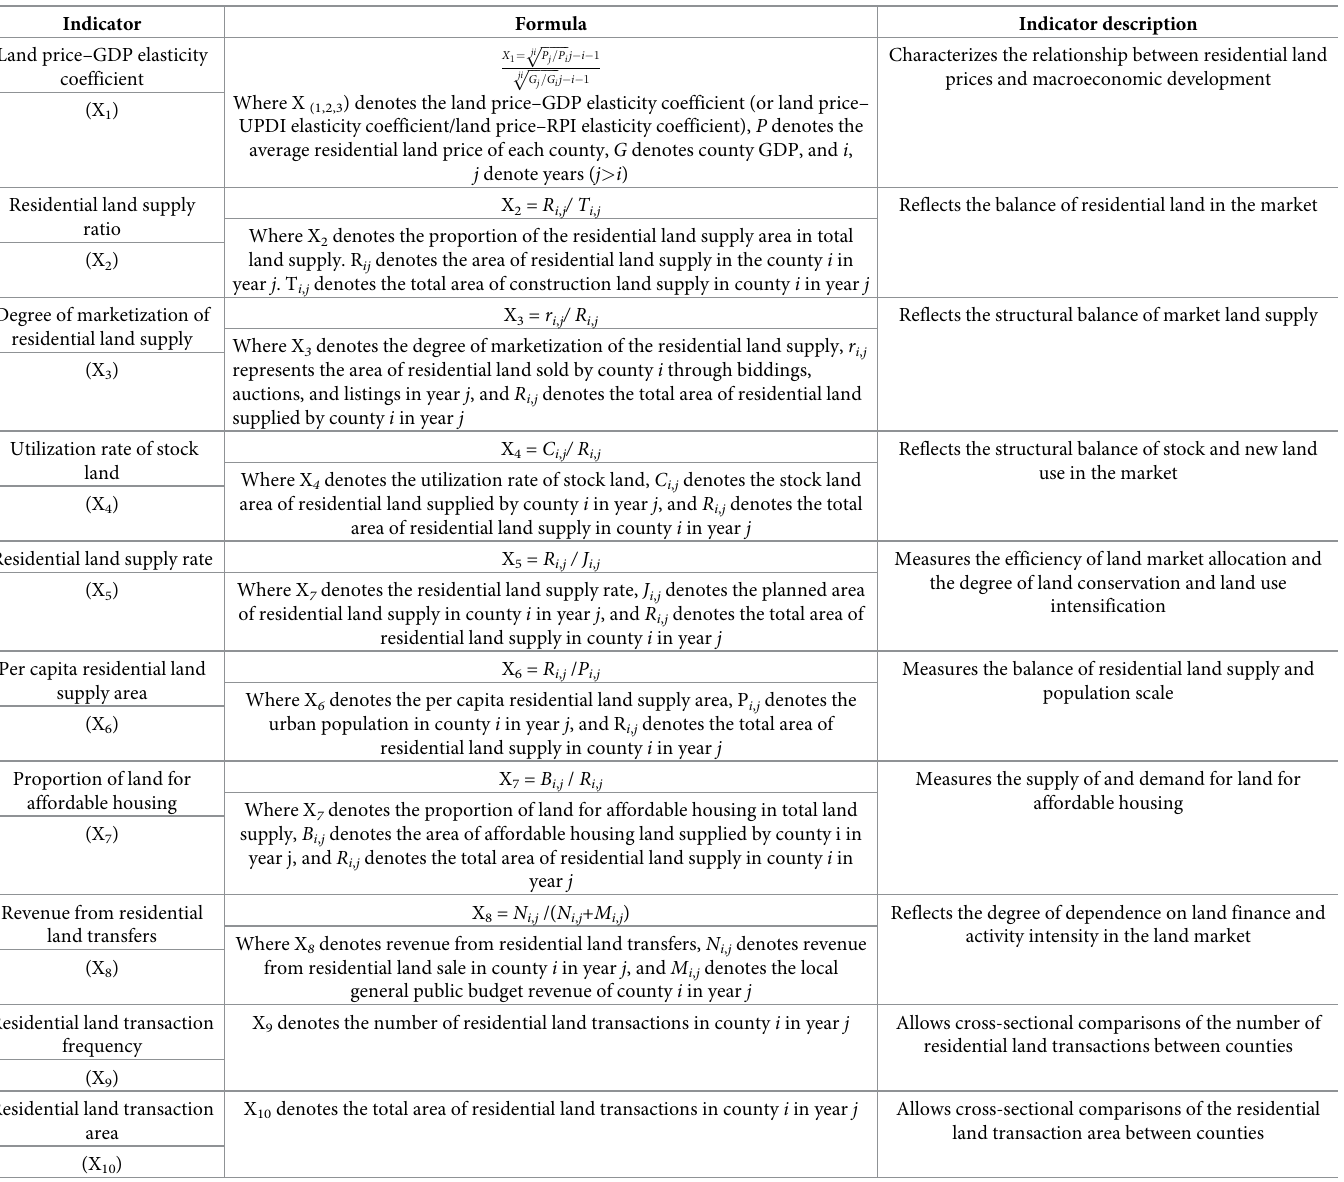
Table 2. Land market indicators affecting residential land